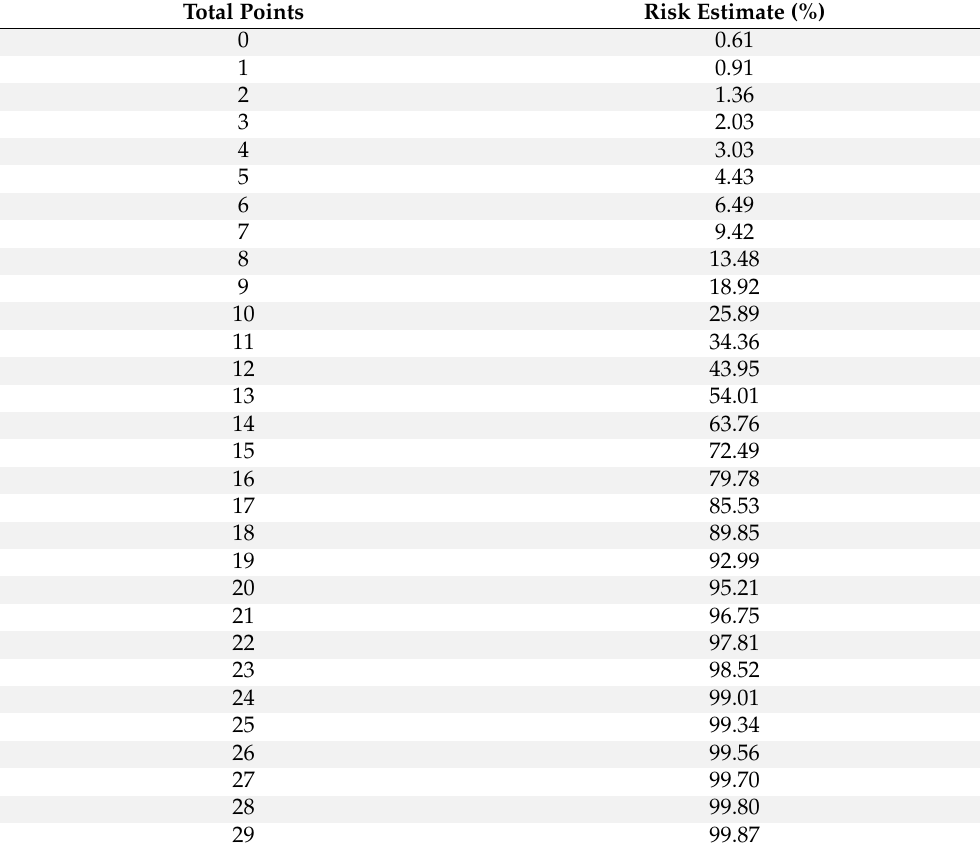
Table 4. Risk estimate for developing CV events within 10 years per total points for HIV-infected